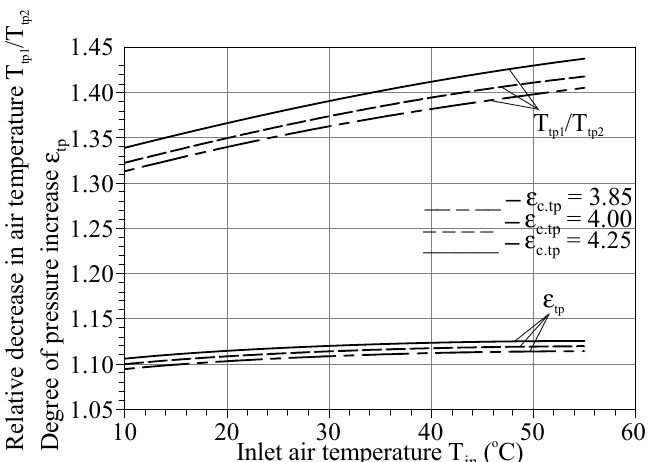
Figure 16. Dependences of the relative decrease in air temperature in the thermopressor T tp1 /T tp2 ; the degree of pressure increase in the thermopressor ε tp at different total pressure increase, ε c.tp , on the inlet air temperature, T in .